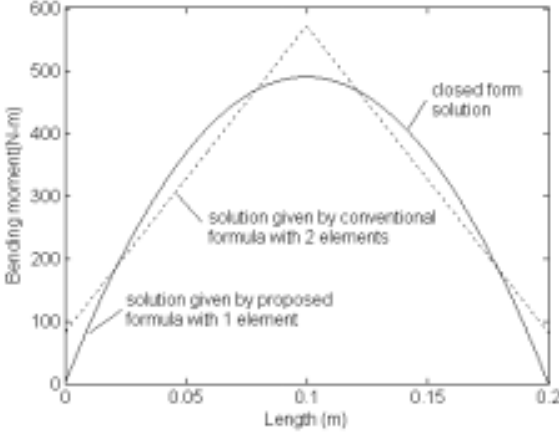
Fig. 6. Bending moment diagrams in a simply supported beam under uniformly distributed